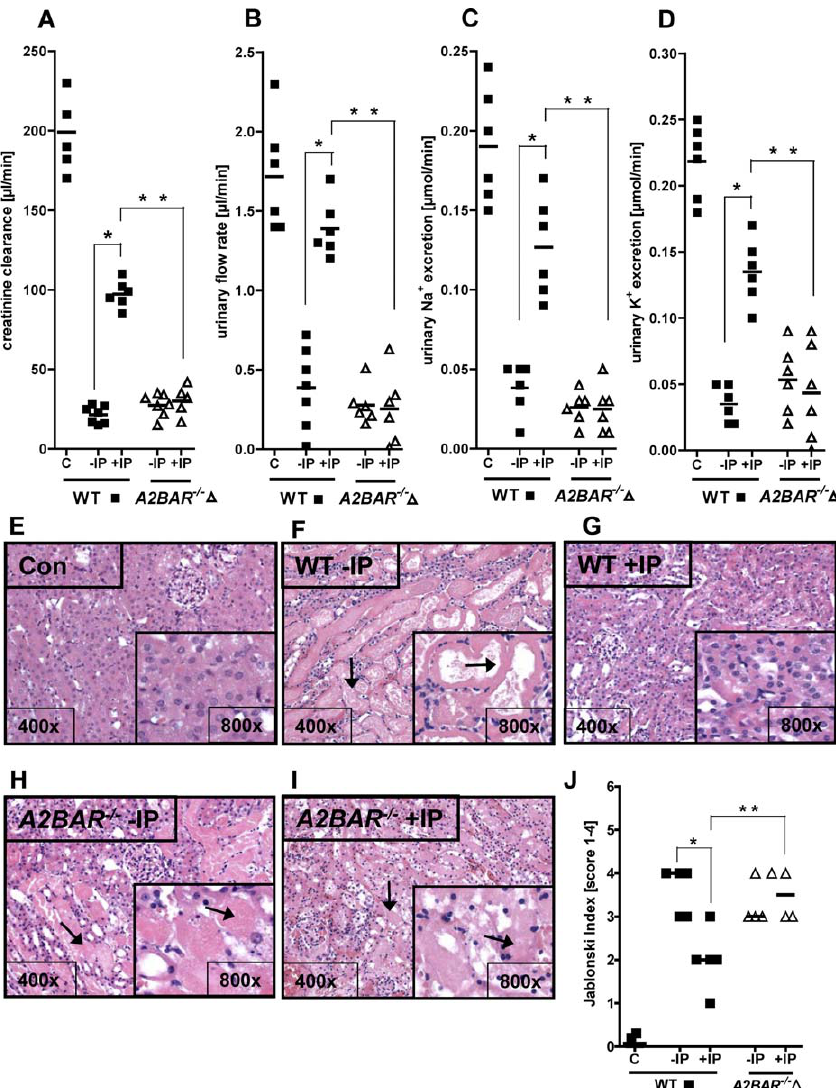
Figure 3. Renal Function and Histology in A2BAR (cid:2) / (cid:2) Mice Exposed to Renal Ischemia or Preconditioning A2BAR (cid:2) / (cid:2) or age-, weight-, and gender-matched littermate controls (WT) were subjected to right nephrectomy followed by 45 min of left renal artery ischemia with or without prior in situ IP (consisting of four cycles of 4 min ischemia followed by 4 min reperfusion). Renal function tests and renal histology were obtained after 24 h of reperfusion. (A) Creatinine clearance. (B) Urinary flow rate. (C) Urinary sodium excretion. (D) Urinary potassium